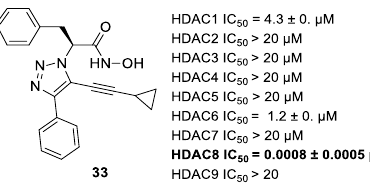
Figure 6. Structure and IC 50 of 32 and 33